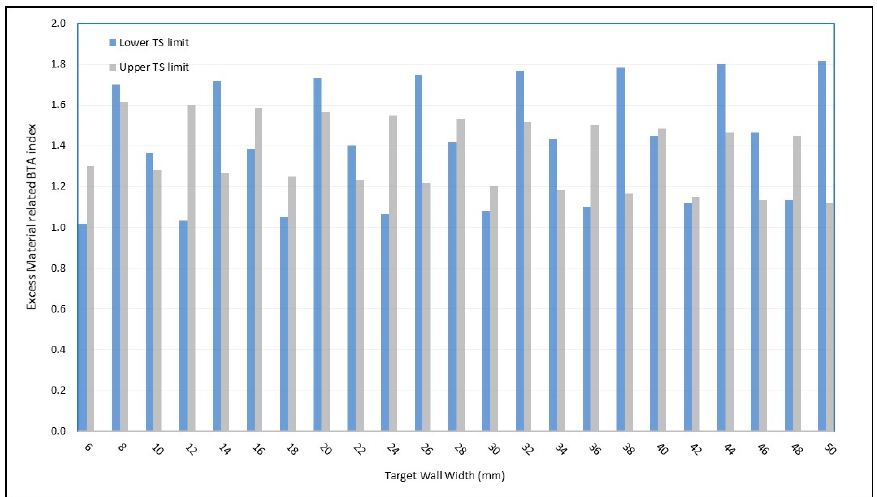
Figure 15. Estimated excess material related Buy-to-Apply index (BTA) as a function of the target wall thickness for WAAM production of aluminum multilayer walls 100-mm high and 200-mm long (no dead time between subsequent layers), by using the lower and upper travel speed limits found in Section